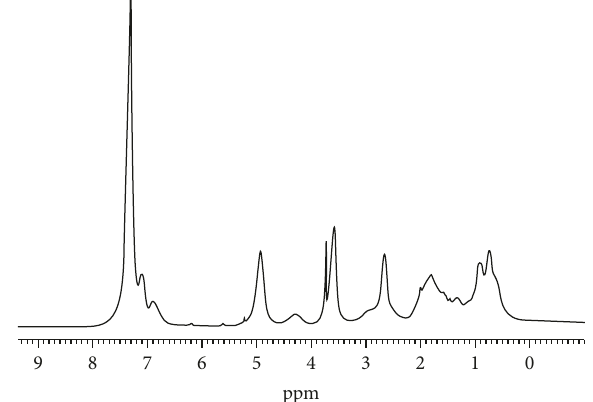
Figure 4: 1 H-NMR spectra of the poly(DEAMSt0.49-co-BMA).